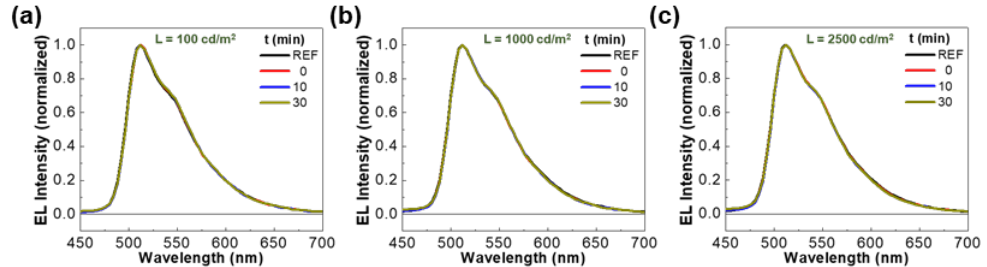
Figure 5. Electroluminescence (EL) spectra for the OLEDs with the P3HT layers annealed at 140 °C for 0, 10, and 30 min at three different levels of luminance (L): ( a ) 100 cd/m 2 , ( b ) 1000 cd/m 2 , ( c ) 2500 cd/m 2 . Note that the OLED without any P3HT layer is marked as REF (reference device).